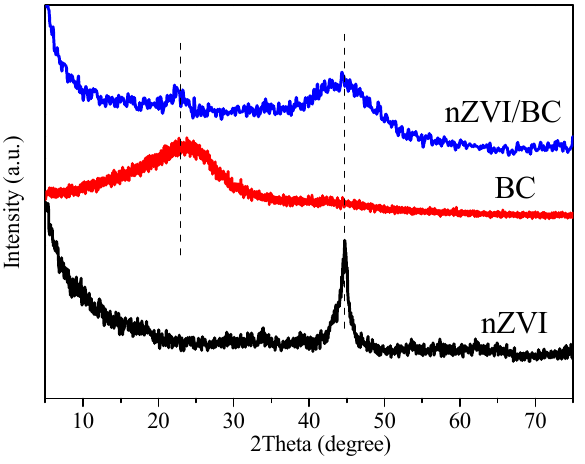
Figure 3. X-ray diffraction (XRD) patterns of nZVI, BC, and nZVI/BC.